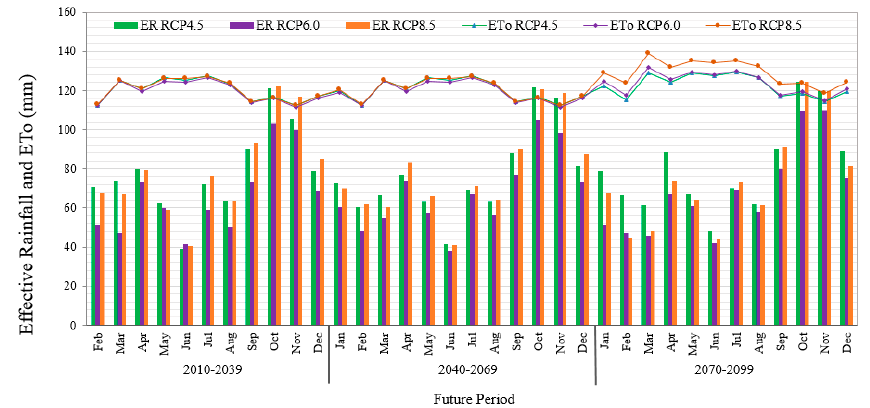
Figure 6. Projected monthly multi-model effective rainfall (ER) and reference evapotranspiration (ET 0 ) for RCP scenarios in future periods (2010–2099). for RCP scenarios in future periods